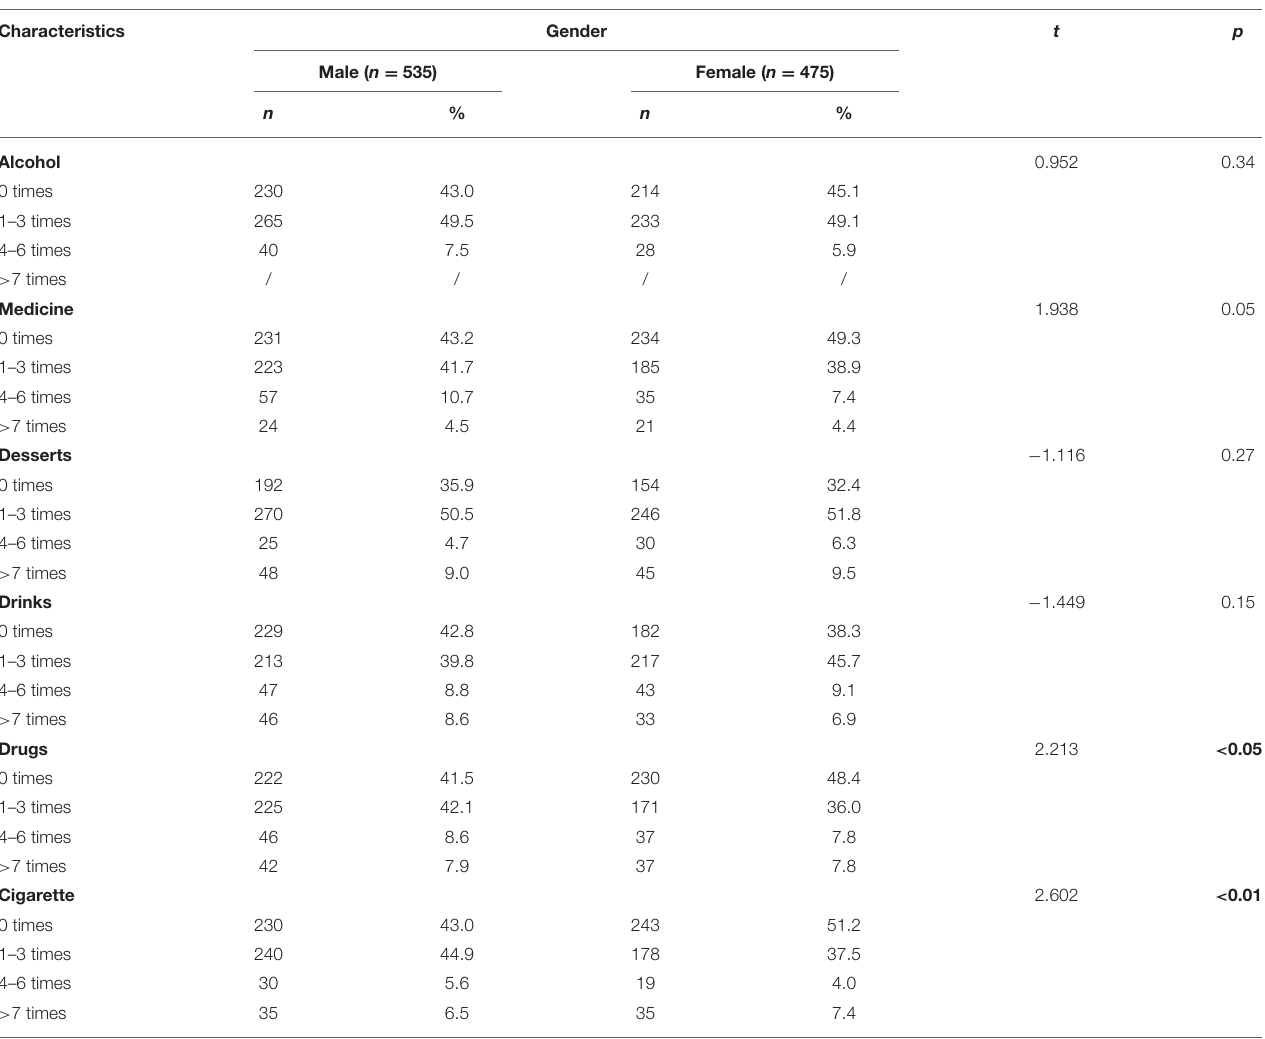
TABLE 2 | Frequency of substance abuse per week of male and female Chinese international college students ( n = 1,010).